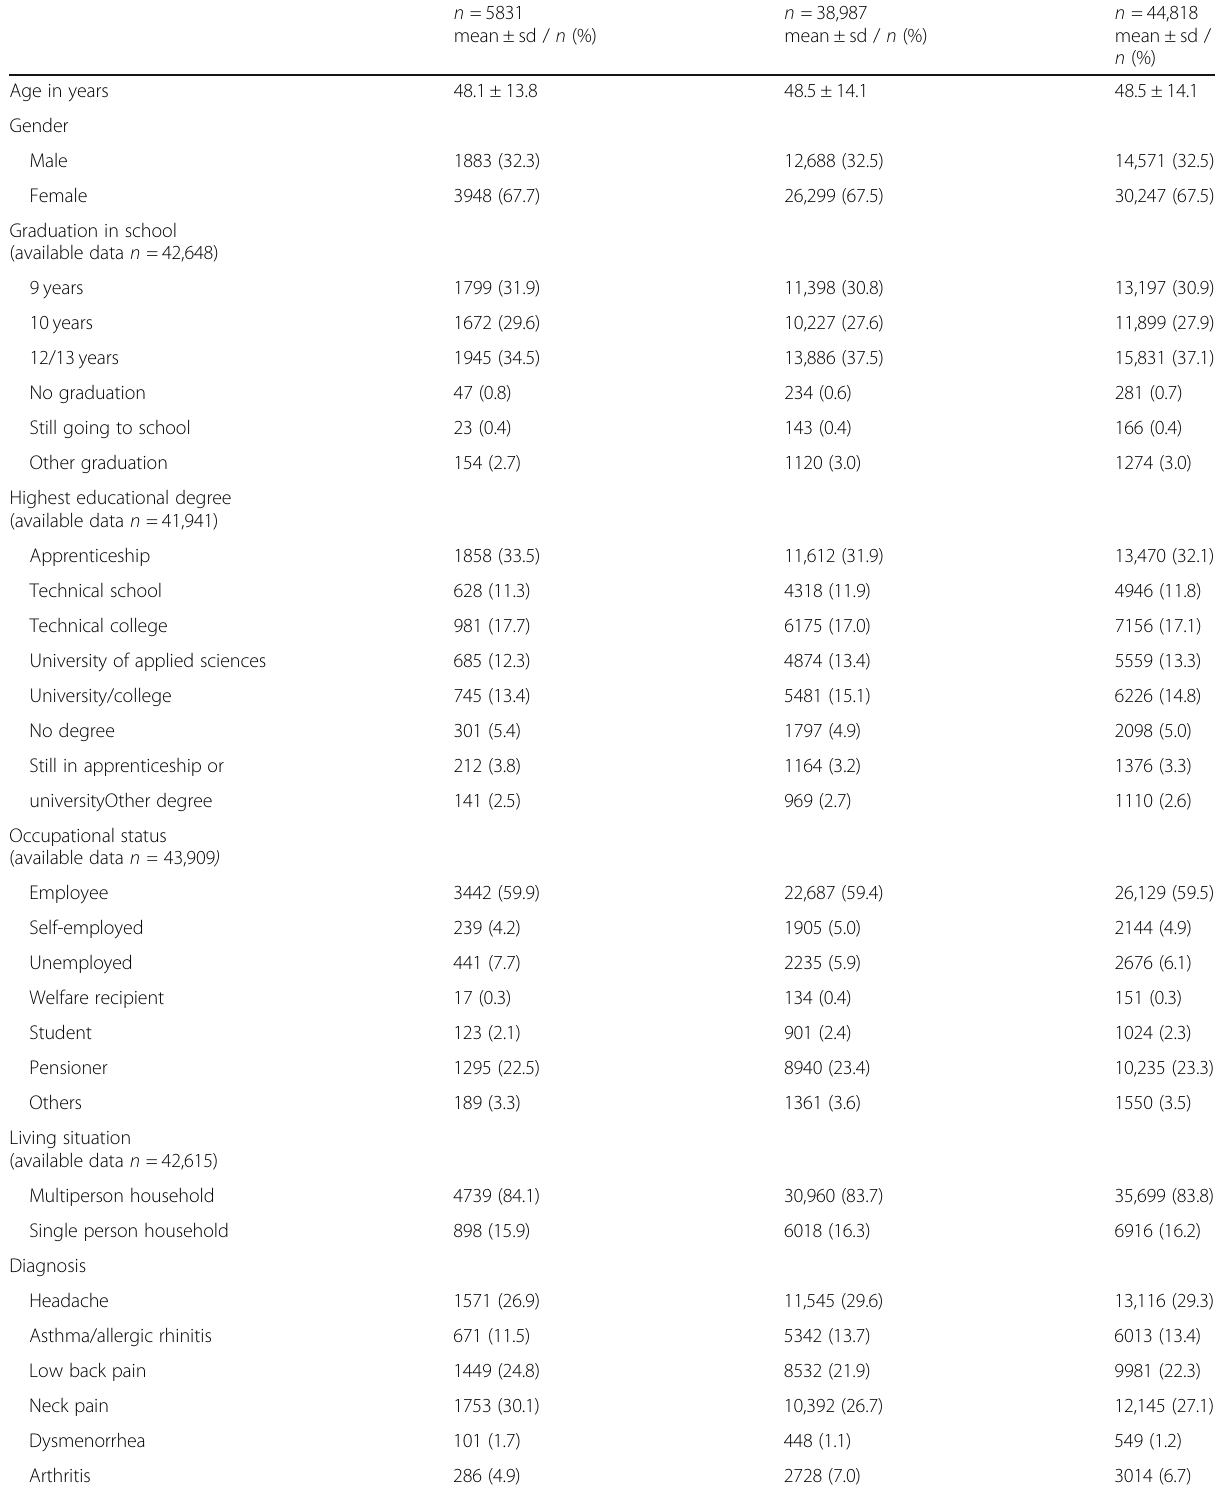
Table 1 Baseline characteristics for the acupuncture in routine care (ARC) patients by the treatment groups